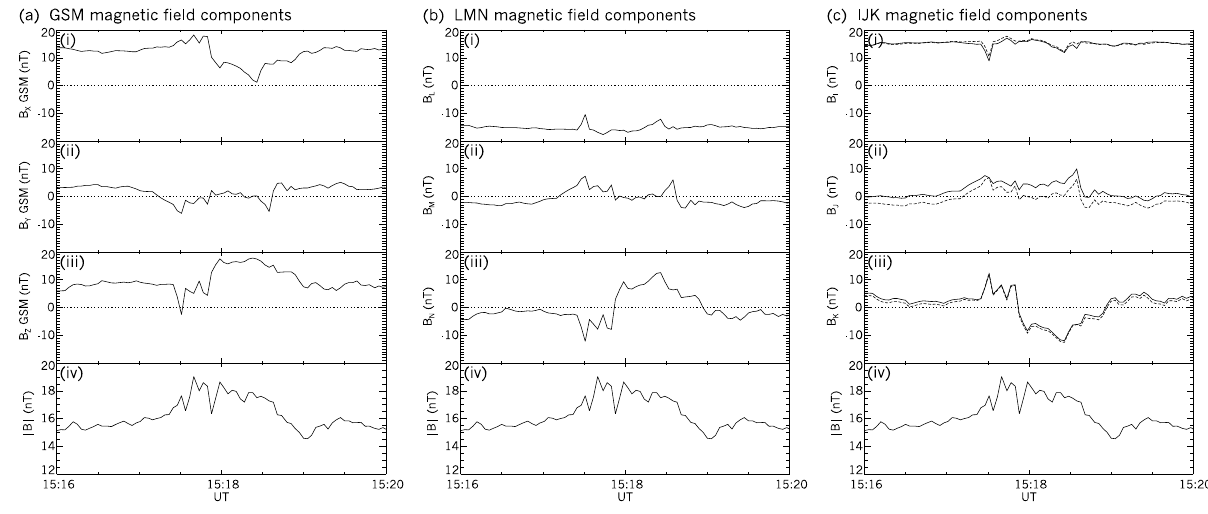
Fig. 6. The field components and strength for the FTE signature centred on 15:18 UT in (a) GSM coordinates, (b) boundary normal LMN coordinates, and (c) local boundary normal IJK coordinates (solid line) and minimum variance coordinates (dashed line) (Sonnerup and Scheible,